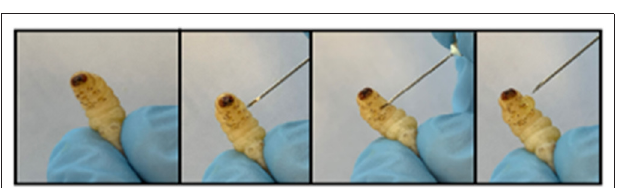
FIGURE 4 | Method for extraction of haemolymph from Galleria larva by piercing the second left proleg.